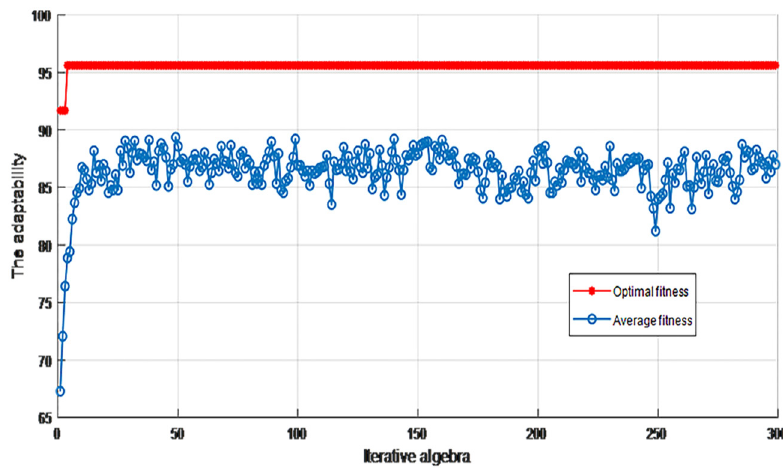
Figure 9: Iterative adaptive graph of the